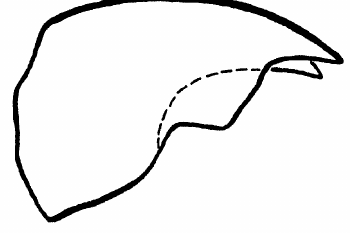
Fig. 4. Mandible of mature larva of A.